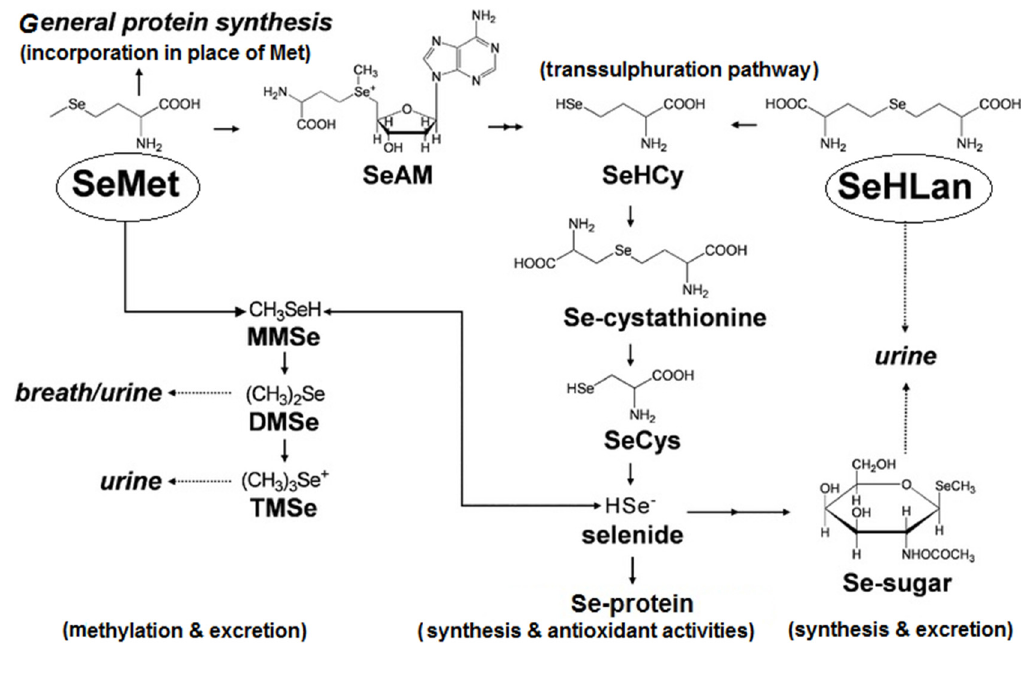
Figure 2. Proposed metabolic pathways for SeHLan and SeMet in animal cells.